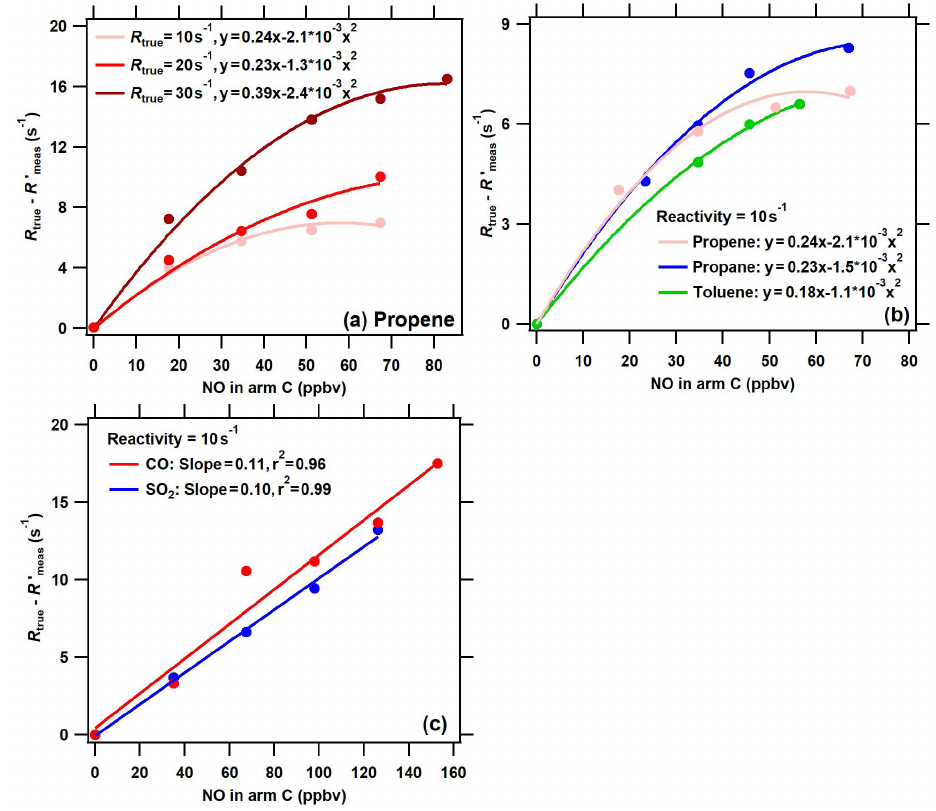
Figure 5. The difference between the true OH reactivity ( R true ) and the corrected measured OH reactivity ( R (cid:48) meas ) using the calibration · R meas ) ) as a function of NO concentrations in arm C in conditions of (a) different levels of VOC reactivity for the factor α 1 ( R (cid:48) meas = ( 1 α VOC same species (propylene), (b) different VOC species for the same OH reactivity level (10s − 1 ), and (c) different inorganic species (red: CO; blue: SO 2 ) for the same OH reactivity level (10s − 1 ). Note that NO, CO, SO 2 , and VOCs were introduced into the reactor through arm